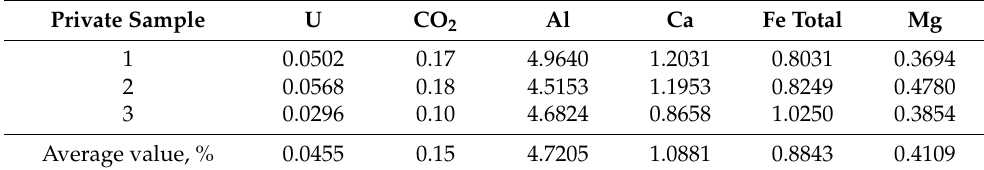
Table 1. Results of analysis of private samples